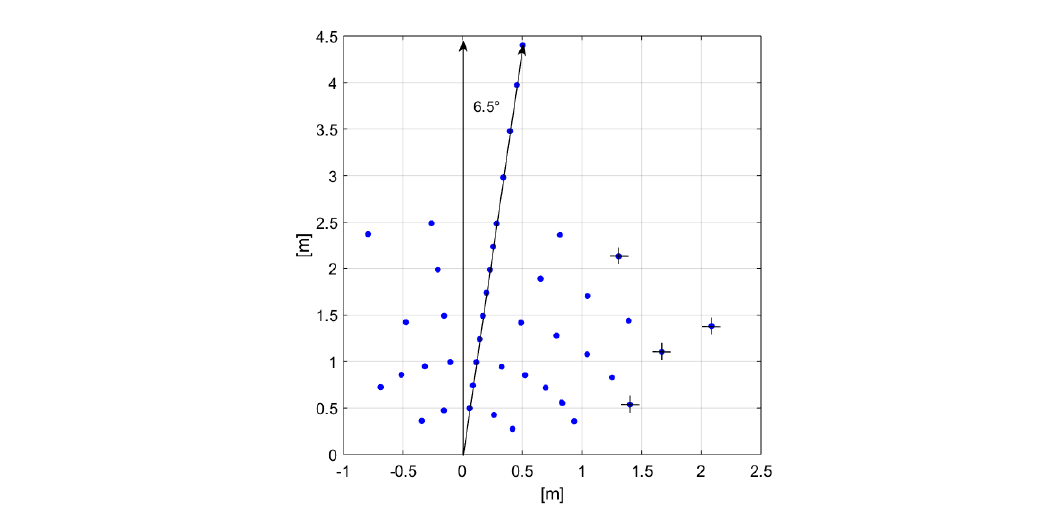
Figure 14. Person’s locations in the room considered for presence detection testing of stationary subjects, applying the angle